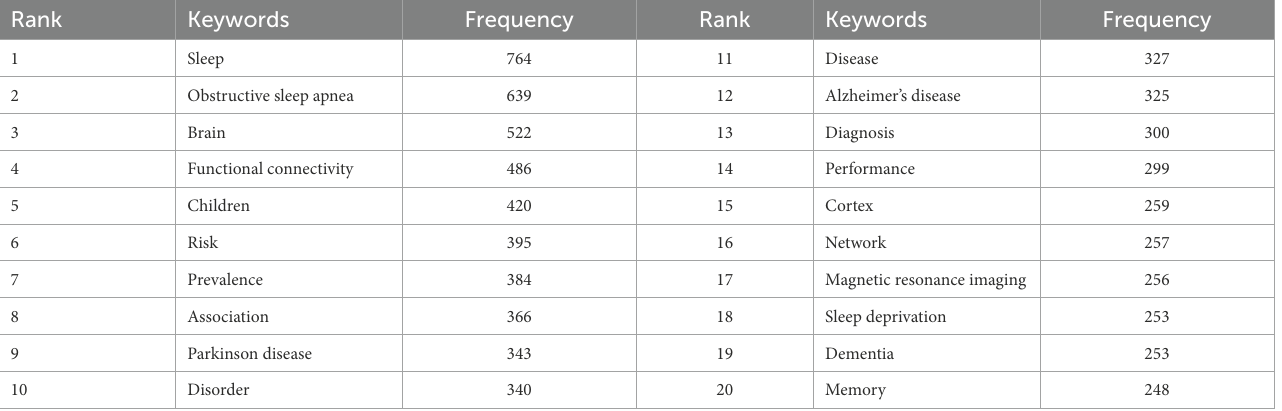
TABLE 4 Top 20 keywords in terms of frequency of appearance.